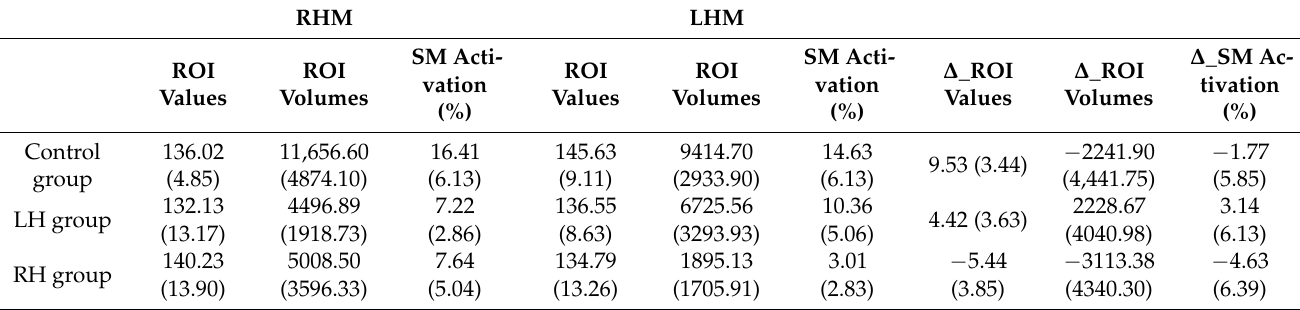
Table 3. ROI parameters associated with hand clenching in the three study